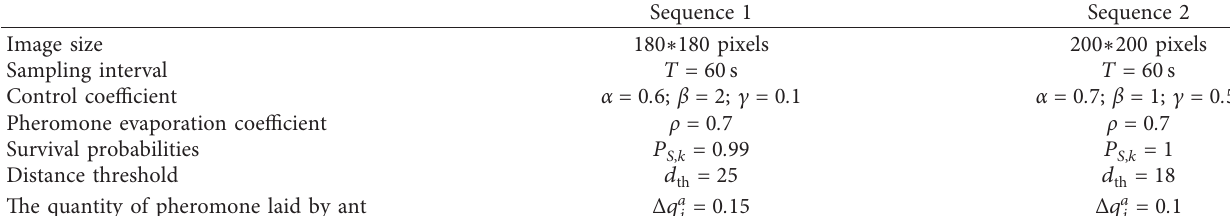
Table 2: Parameter settings on various sequences.